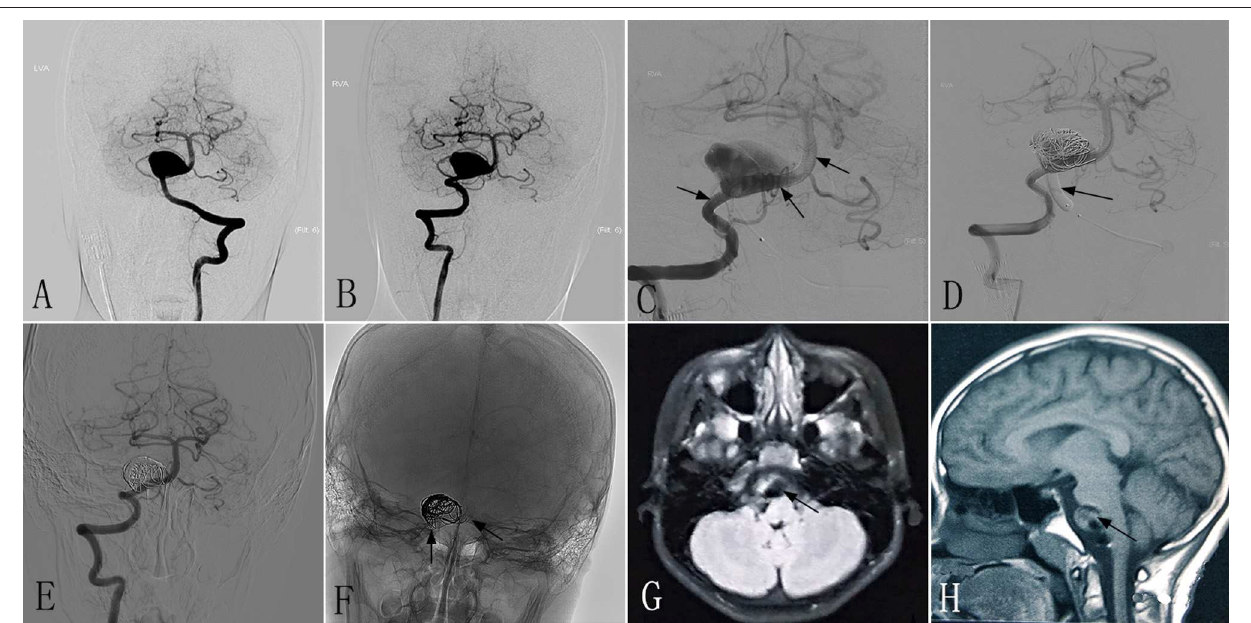
FIGURE 2 | Images from an 8- to 10-year-old patient with a giant dissecting aneurysm located in the VBJ (case 2). (A,B) Preoperative anteroposterior angiograms of the LVA (A) and RVA (B) showing a giant dissecting aneurysm in the VBJ. (C) Intraprocedural unsubtracted view showing the successful insertion of PEDs (3.5 × 35mm) (black arrow). (D) Intraprocedural angiogram showing complete occlusion of the LVA by a balloon (black arrow). (E,F) Six-month postoperative angiograms showing the reconstruction of the RVA (E) and stable PEDs (F) (black arrow). (G,H) Six-month postoperative MRI showing a mass effect with a diameter of 20 × 15mm (black arrow). VBJ, vertebrobasilar junction; LVA, left vertebral artery; RVA, right vertebral artery; PED, pipeline embolization